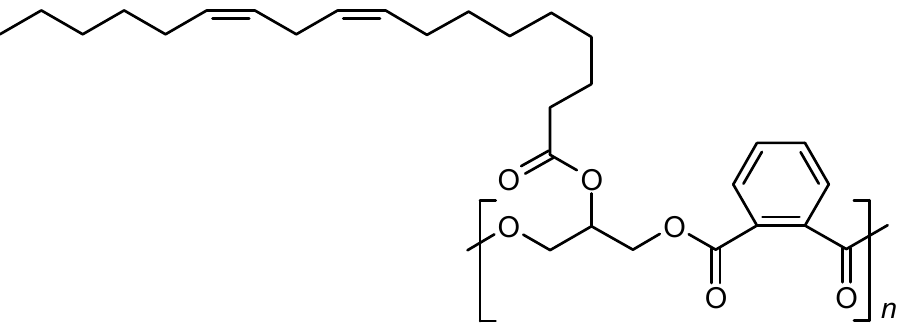
Figure 1. Structure of a typical alkyd resin with linoleic acid as side group.